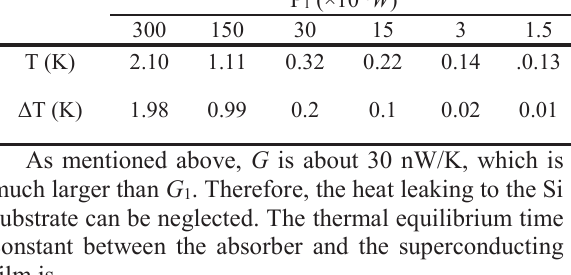
Fig. 4. The structure diagram of Model B. Replaced the absorber, the superconducting film, and the thermalization layer with a cubic thermistor.